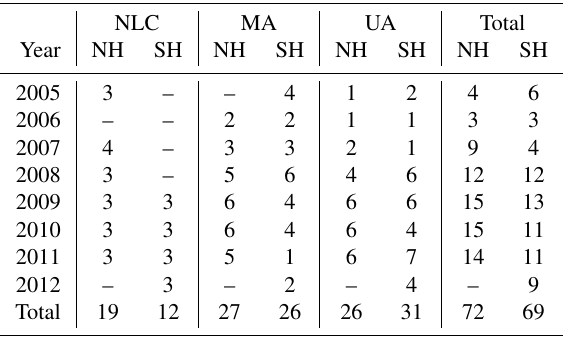
Table 2. Distribution of MIPAS days of observation of PMCs per season ∗